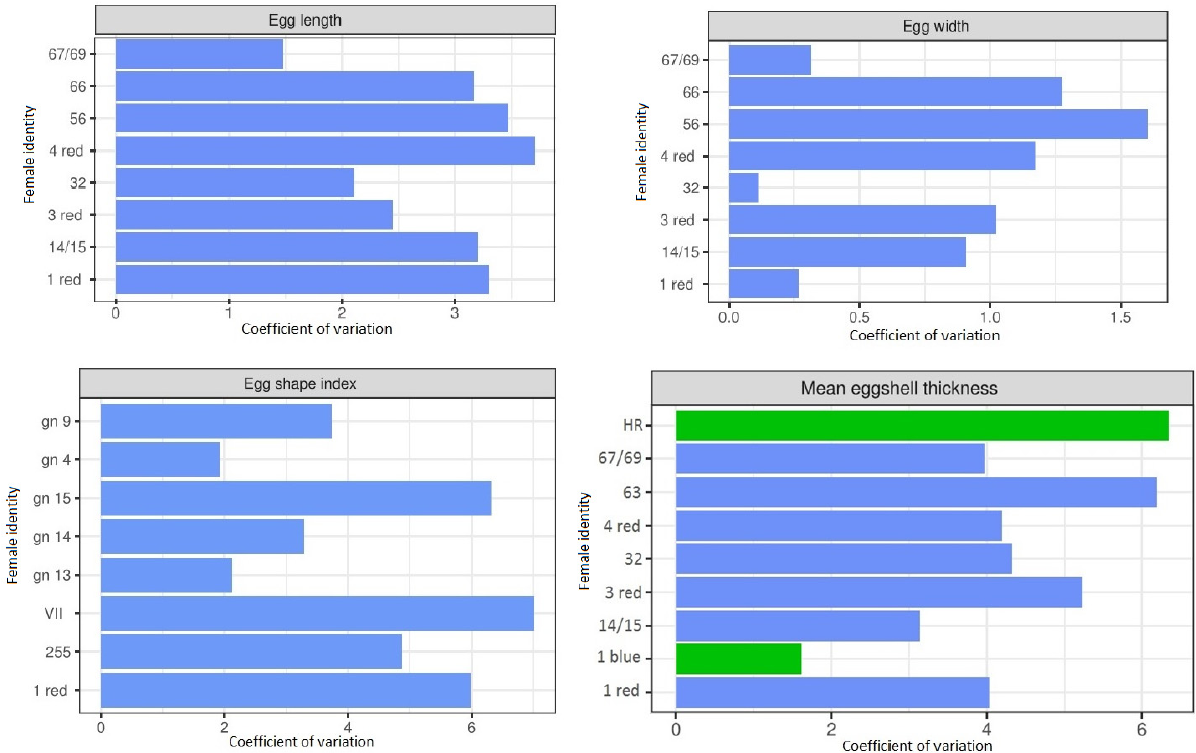
Figure 1. Coefficient of variation for egg length, width, egg shape index and mean eggshell thickness for particular females in the year 2018. The compared unfertilized eggs are marked in blue, the post-hatched eggshells are marked in green. Table 2. The length, width, shape, and eggshell lightness of Capercaillie eggs collected from Wis ł a